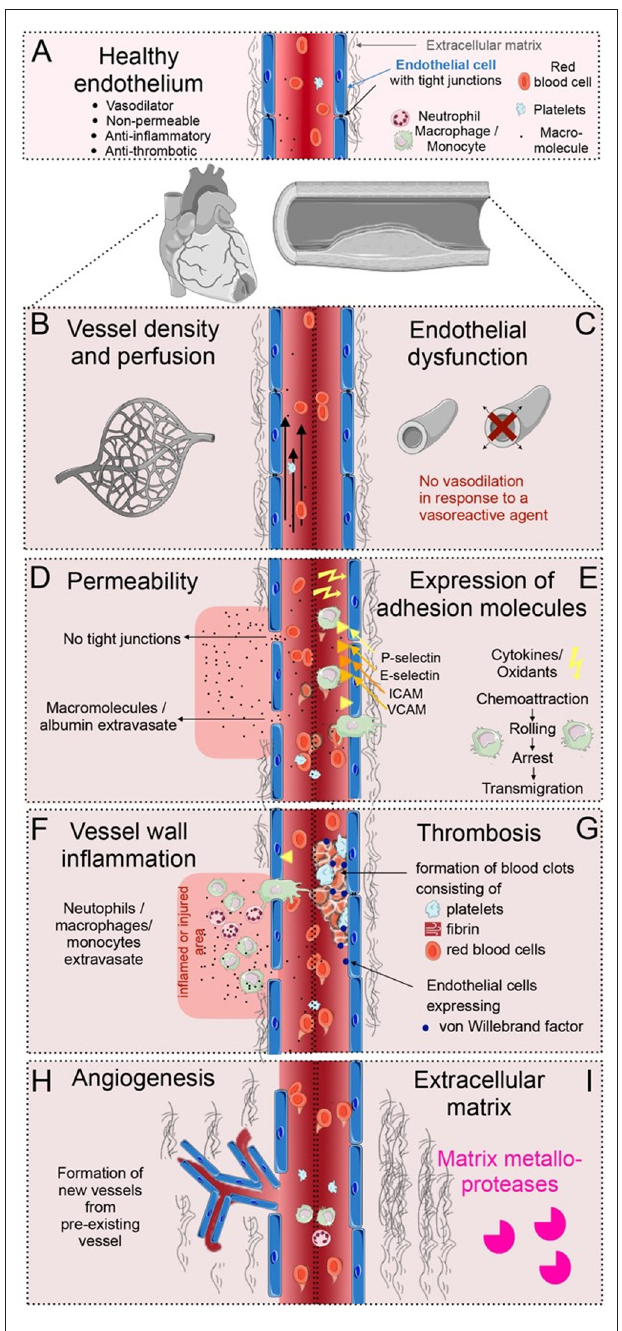
FIGURE 1 | Overview of vascular processes in cardiovascular disease (CVD). (A) The healthy endothelium of the heart and the large vessels, is able to dilate, is non-permeable, anti-inflammatory and anti-thrombotic, with tight junction between the endothelial cells, and a balanced amount of extracellular matrix (ECM) surrounding the vessels. (B) Alterations in the vessel density and perfusion occur during CVD. (C) Endothelial dysfunction is a condition that occurs early in the pathogenesis of CVD, debilitating the local vasodilator response to vasoactive agents. (D) Vascular permeability occurs when tight junctions between endothelial cells loosen; molecules and proteins can then extravasate from the circulation. (E) Adhesion molecules occurring in specific regions of the vasculature slow down leukocytes at specific regions of